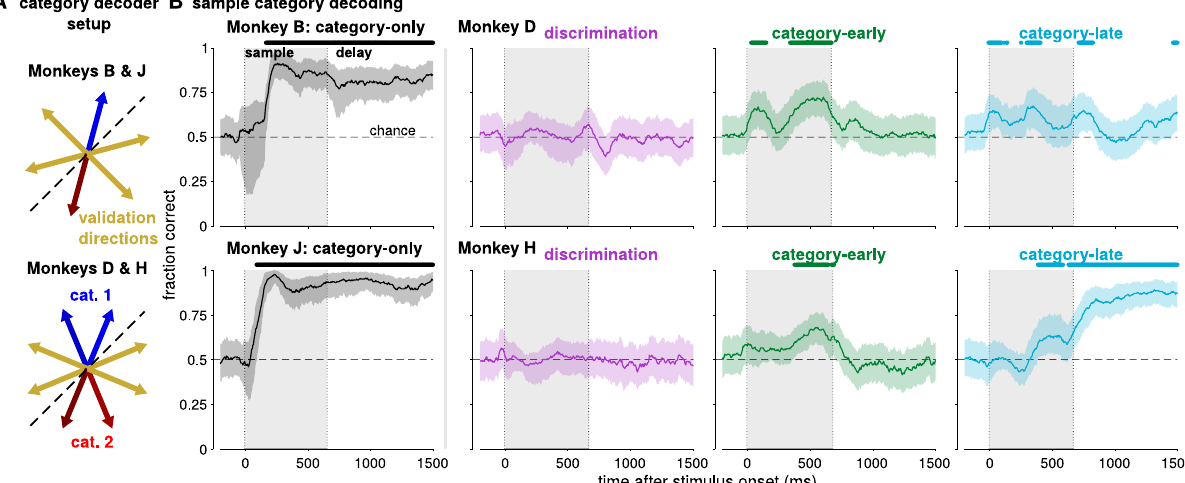
Fig. 8 | Category and direction decoding in LIP. A The training and test scheme for a direction-independent category decoder. Pseudopopulation trials were cre- atedfrom50randomtrialssampledwithreplacementforeachdirectionfromeach cell. For monkeys B and J, the decoder is trained using one direction from each category (180° apart; red and blue) and validatedon the remaining four directions (yellow).FormonkeysDandH,thedecoderistrainedusingtwoadjacentdirections from each category (again using opposite directions from each category; red and blue) and validated on the remaining four directions (yellow). B Median decoder generalization performance as a function of time for each of the eight LIP